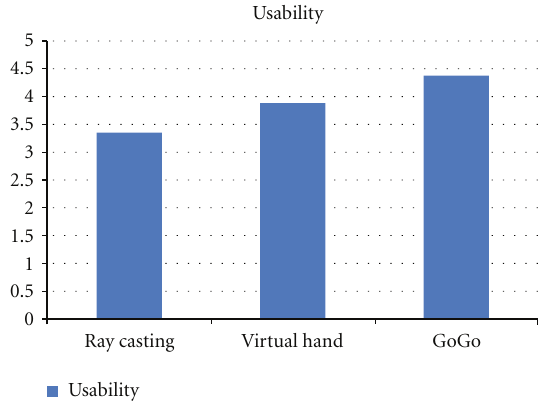
Figure 12: Mean di ff erence in the